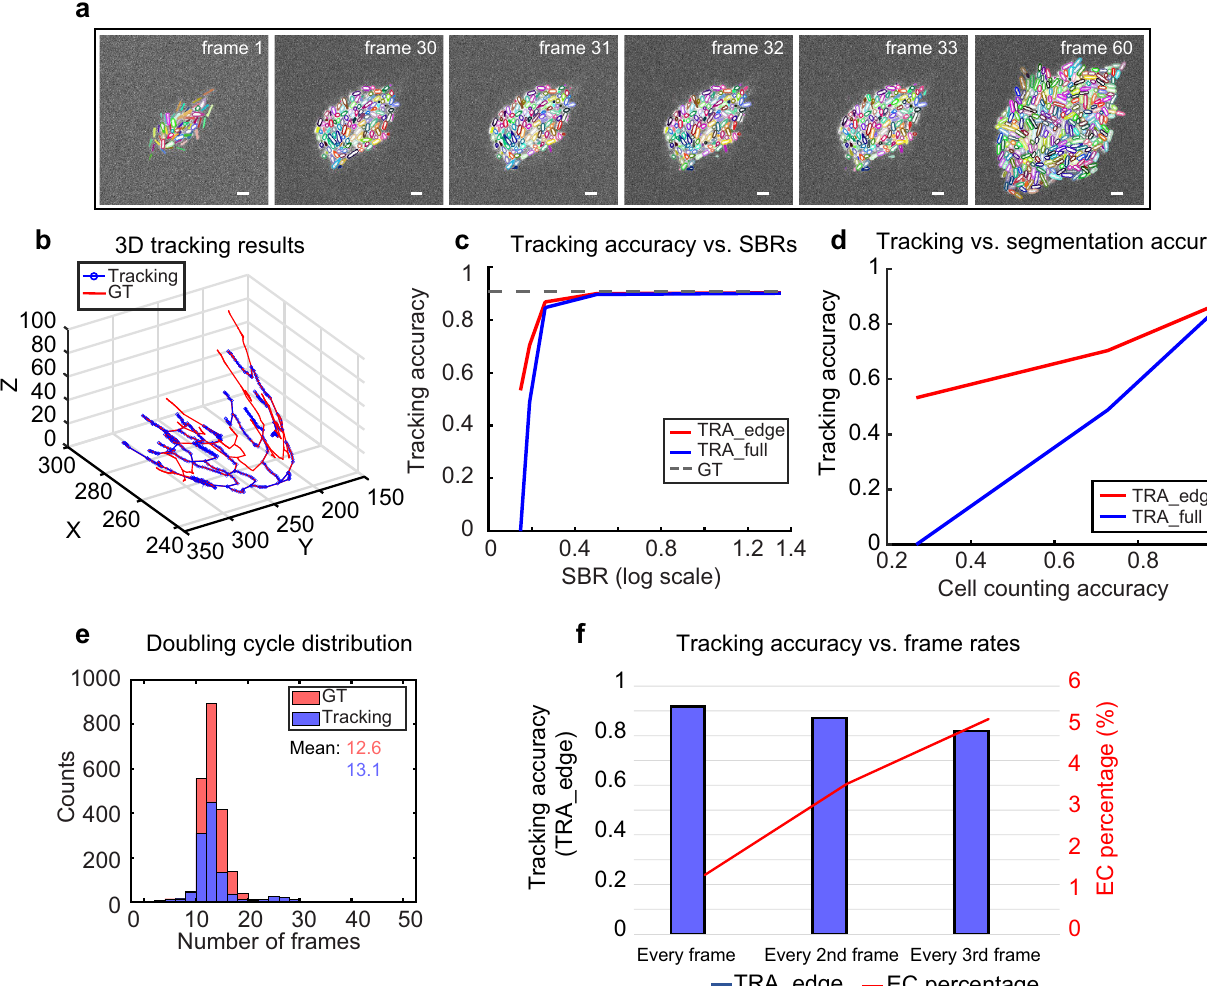
Fig. 3 Multi-cell tracking in simulated bio fi lms. a Simulated fl uorescence time-lapse images of growing E. coli -like bio fi lm. The SBRs of these images are ~1.65. Contours are color-coded based on segmentation and tracking results. Scale bars are 2 µm. b An example of 3D tracking and lineage tracing for simulated bio fi lm images. For clarity, spatial trajectories and lineages originating from only a single ancestor cell are displayed. The estimated graph is shown in blue and the corresponding ground truth graph is shown in red. The entire bio fi lm contains over sixty graphs of this type. c Two AOGM metrics calculated as TRA_edge and TRA_full are plotted against image SBR. The gray dashed line indicates tracking of the GT segmentation using the same tracking algorithm. d Same data as in c plotted as a function of cell counting accuracy at IoU = 0.5, a segmentation accuracy metric that increases for increasing SBR in the raw images 23 . e Doubling cycle distribution of simulated data and corresponding tracking results. A completed cell cycle is de fi ned as a track in which the parent cell is able to split twice. This threshold results in a lower count numbers of estimated cell division, but does not alter the shape of the distribution. f TRA_edge (left axis) and edge-correction (EC) percentage (right axis) for different temporal sampling rates. EC percentage indicates how many parent-daughter relationships are misassigned based on the tracking